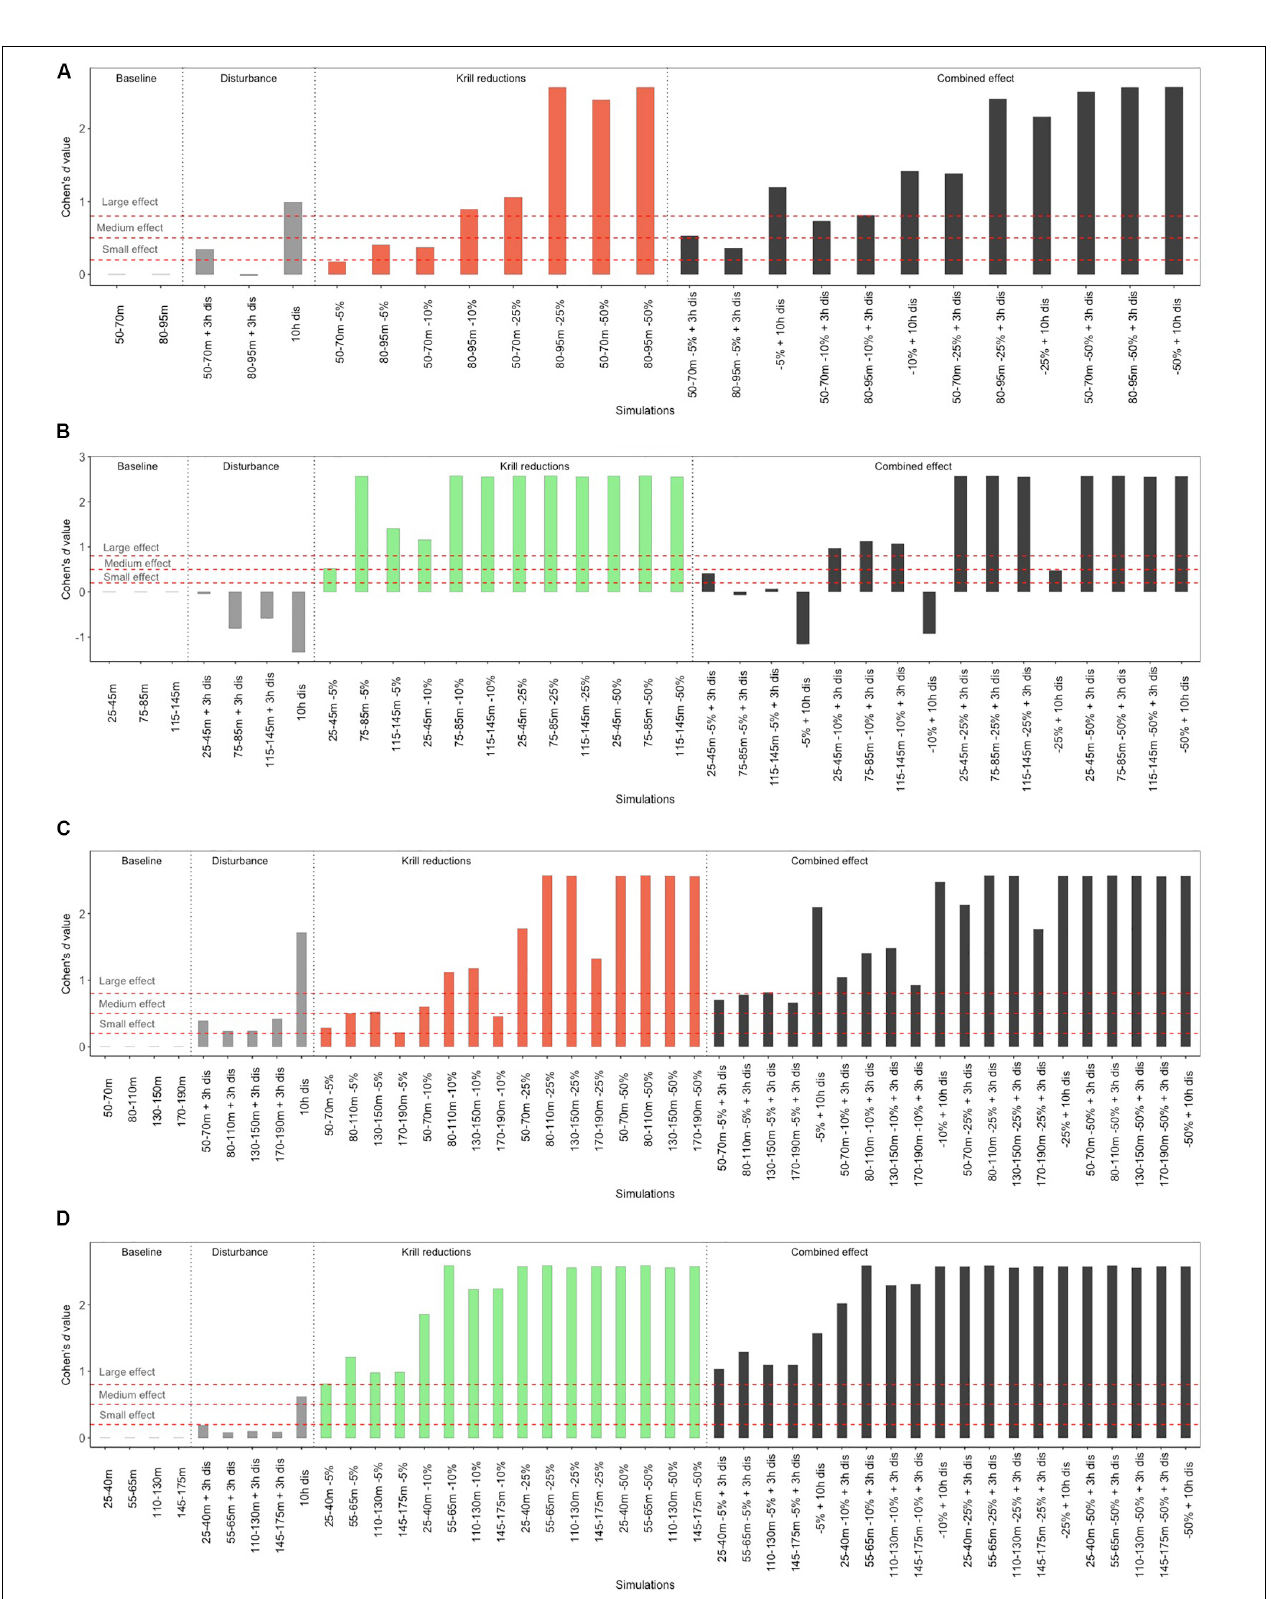
FIGURE 5 | Effect of the various scenarios on net energy gain after a 10 h foraging period of a blue whale feeding on (B,D) Thysanoessa spp. or (A,C) M. norvegica , (A,B) in the St. Lawrence Estuary and (C,D) in the North western Gulf of St. Lawrence. The red dashed lines represent the threshold values of Cohen’s d above which effects are considered small (0.2), medium (0.5), and large ( > 0.8). Negative Cohen’s d value indicates a positive effect.